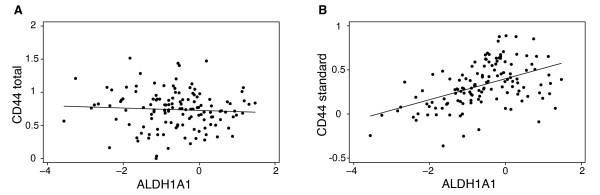
Association between CD44 and ALDH1A1 expression in primary breast cancer. A. Gene expression of the total CD44 shows no significant correlation to expression of ALDH1A1 (Spearman ρ = -0.10, P = 0.28; n = 131). B. The gene expression of CD44 standard isoform was positively correlated to expression of ALDH1A1 (Spearman ρ = 0.49, P < 0.00001; n = 131).